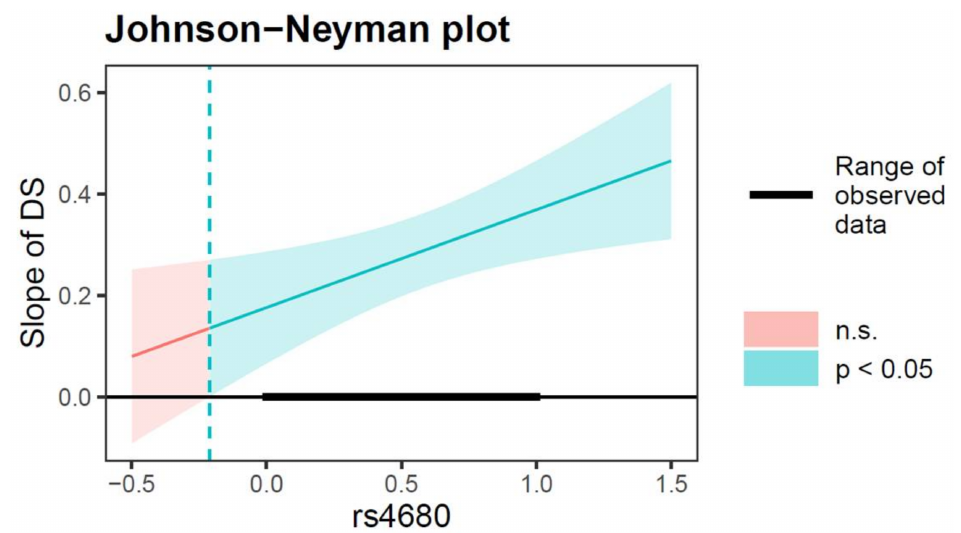
Figure 3. Interactive effect of DS and rs4680 polymorphism on adolescent NSSI. The green-red line indicates the simple slope of DS contribute to NSSI. Note: The green line represents the region of significance for the conditional association. Shaded area = confidence interval, DS = depressive symptoms, n.s. = not significant = CI [ − 5.47, − 0.21], the rs4680 value (1 = Val/Val, 0 =